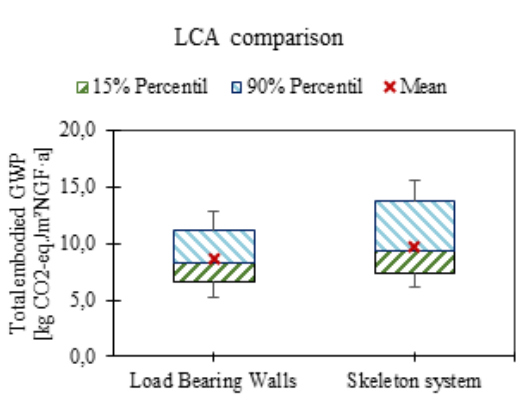
Figure 5. Boxplot showing LCA result for different structural systems based on 50 real-world